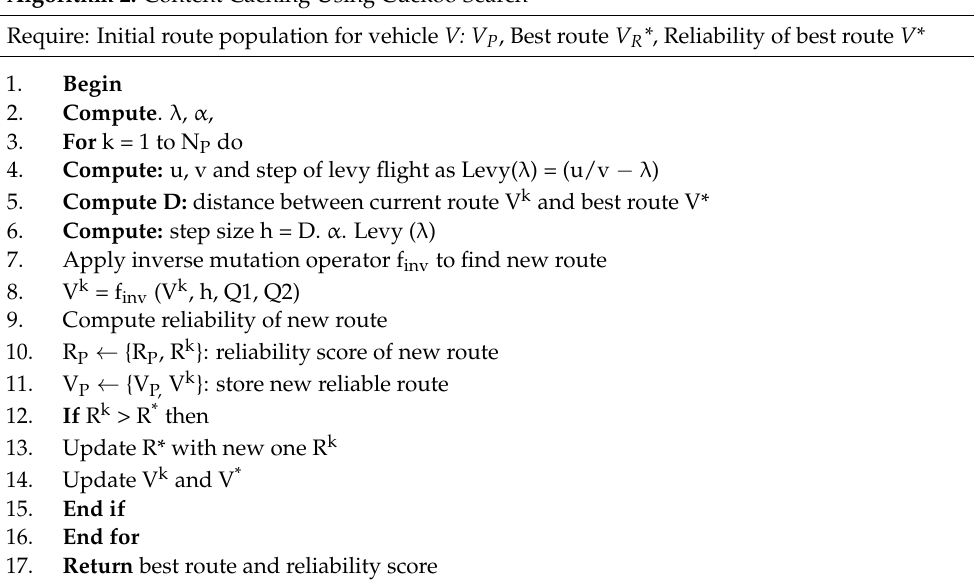
Algorithm 2: Content Caching Using Cuckoo